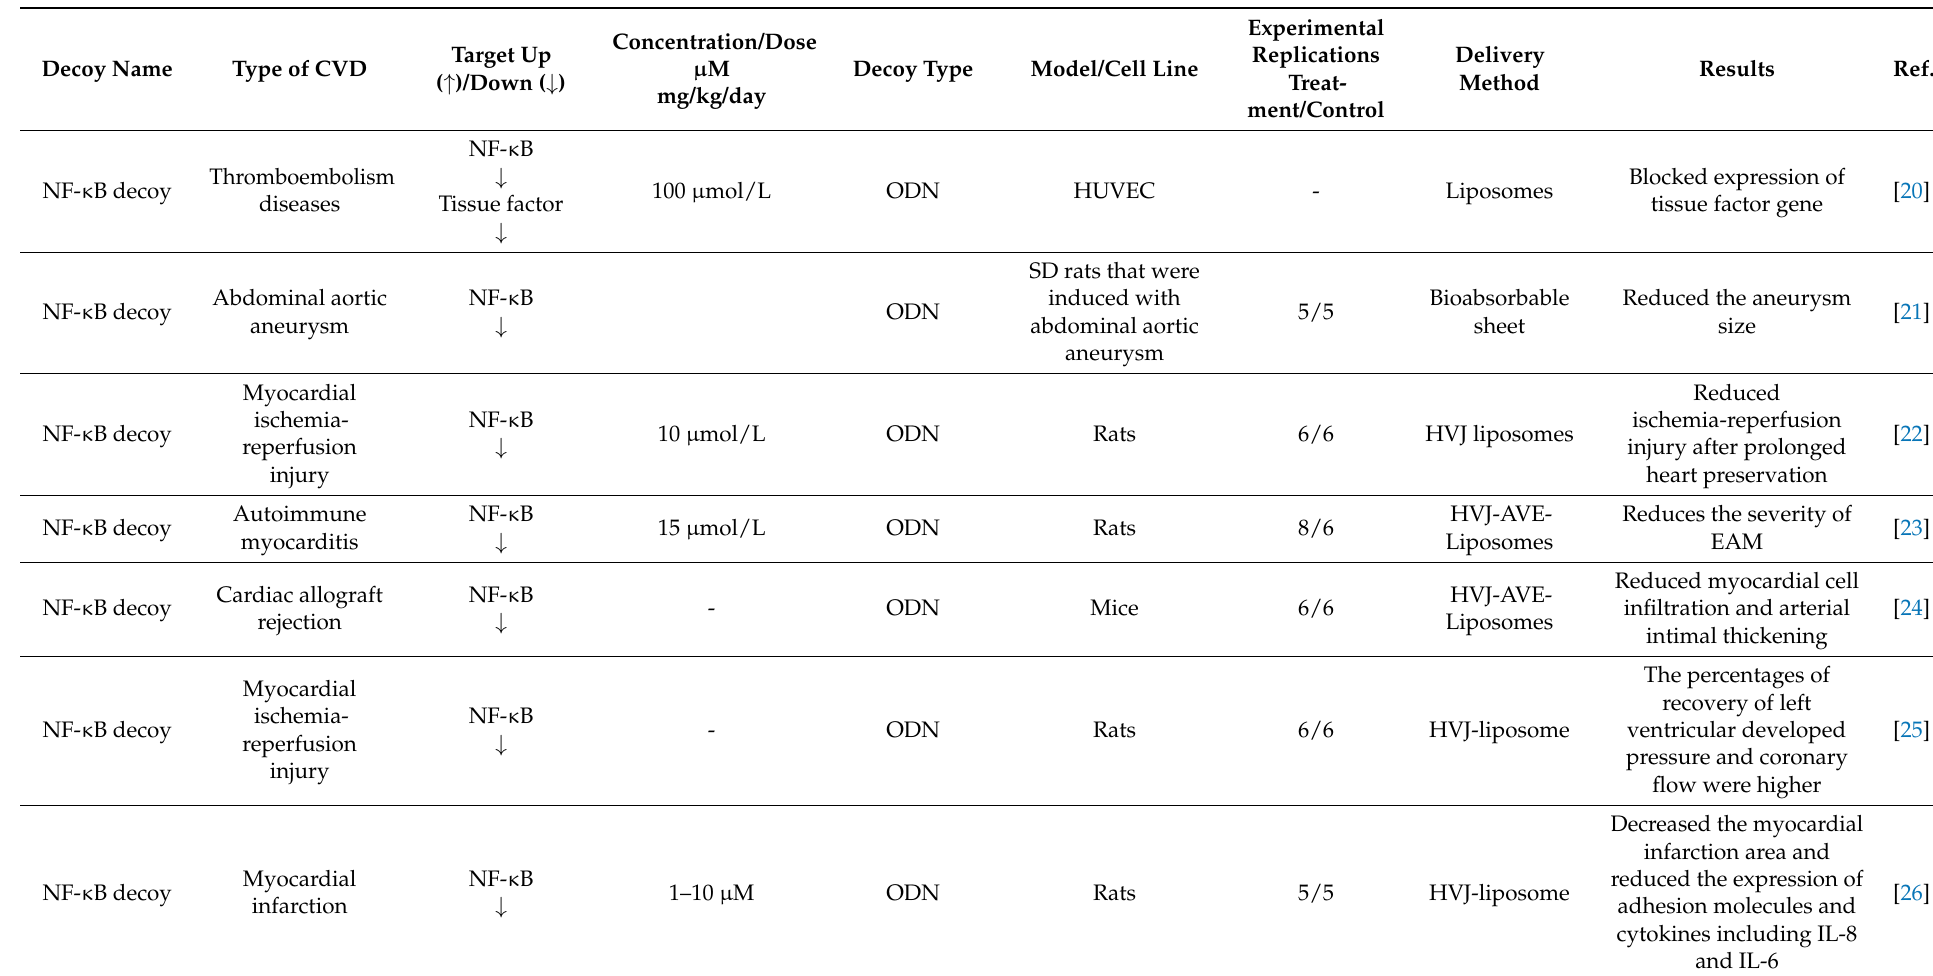
Table 1. Therapeutic effects of oligodeoxynucleotides (ODN) and peptide decoy on non-atherosclerotic